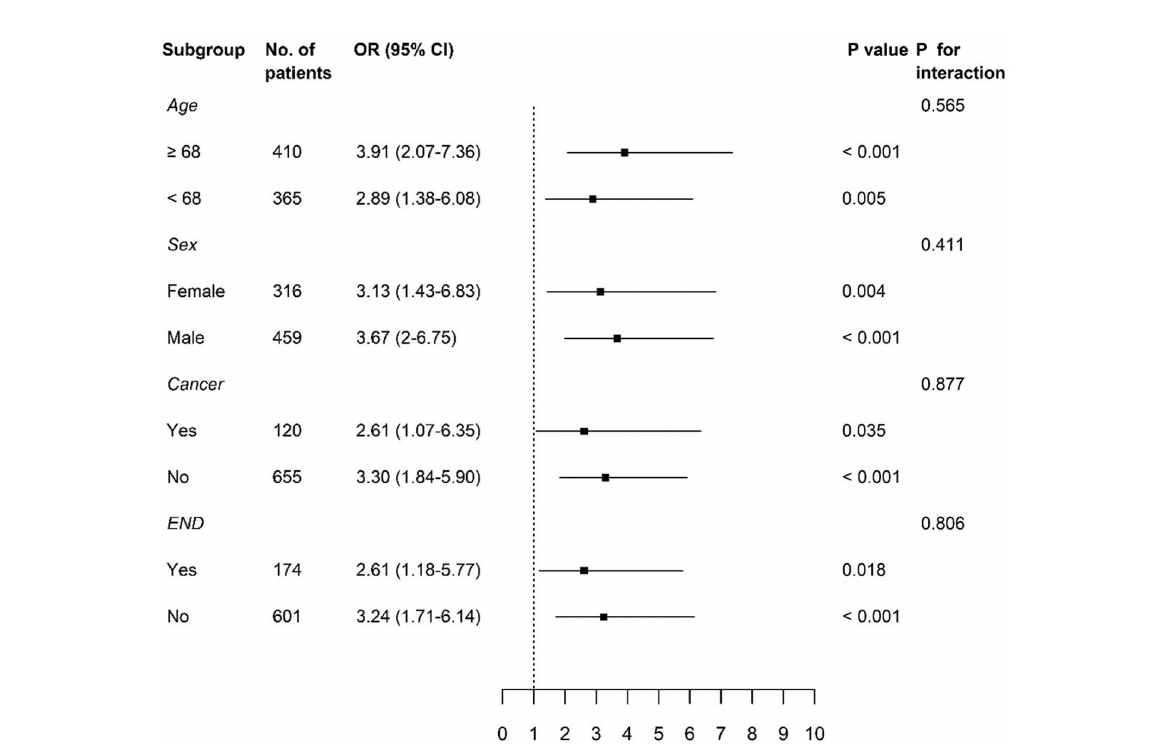
FIGURE3 Subgroup analyses of adjusted odds ratios of PHQ-9 positive group for poor functional outcome at 3 months. PHQ-9, Patient Health Questionnaire-9; OR, odds ratio; CI, confidence interval; END, early neurological